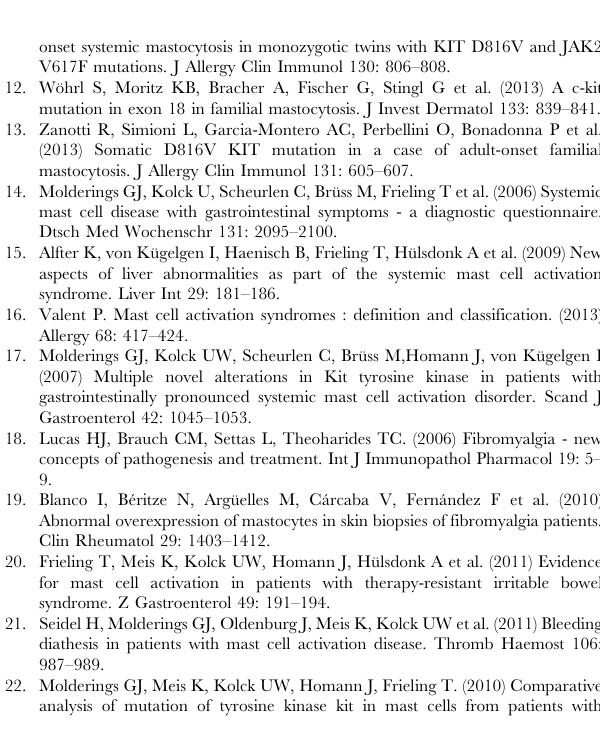
Figure S1 Pedigrees of two families (A, B) with high familial loading of mast cell activation disease. Filled symbols indicate family members with either systemic mastocytosis